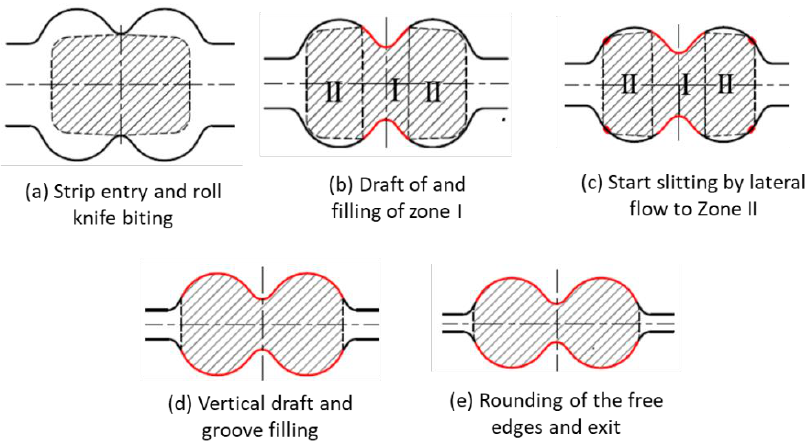
Figure 20. Schematic representation of the deformation stages at stand 15 (preparation stage for slitting) of the single barreled strip resulting from the edging process at stand 14.